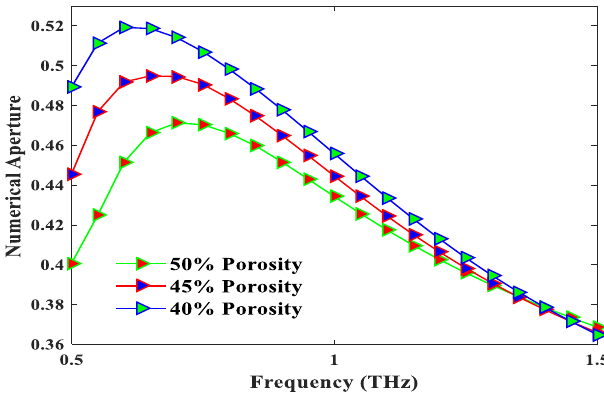
Figure 2. The numerical aperture as a function of frequency and